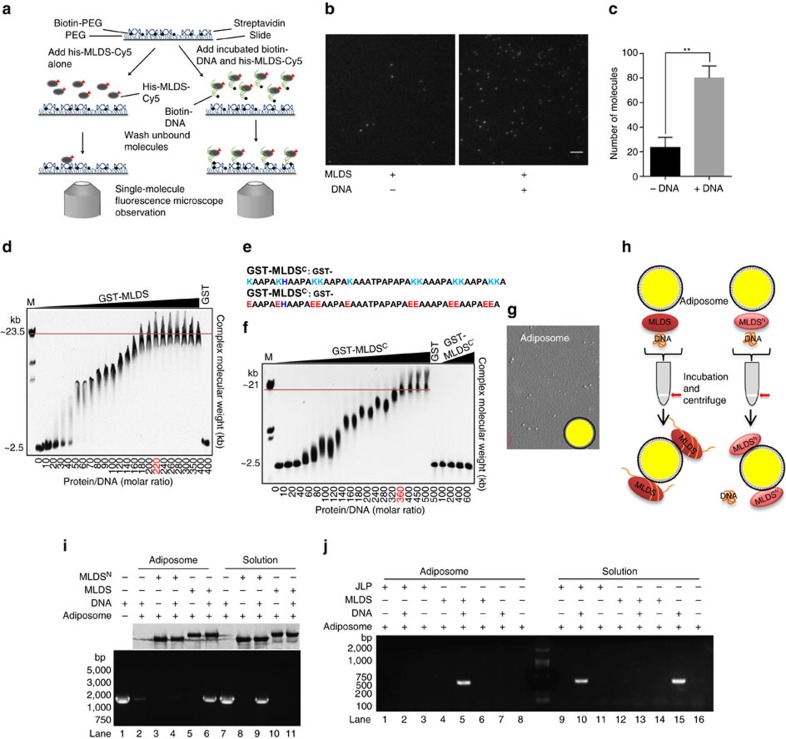
Lipid droplets bind DNA through MLDS in vitro.(a–c) Interaction between DNA and MLDS was detected by single-molecule pull-down assay. Biotin-labelled DNA was incubated with Cy5-labelled MLDS, and the mixture was immobilized onto the streptavidin-coated coverslips and Cy5-labelled MLDS was observed. Sketch (a), validation (b) and quantification (c) of single-molecule pull-down assay were shown. The Cy5-labled MLDS non-specificly bound to the PEG-passivated surface is shown in left. Scale bar, 3.5 μm. Data represent mean±s.d., n=3. **P<0.01, two-tailed t-test. (d) EMSA analysis of the interaction between DNA and MLDS. A dose dependent binding of GST-MLDS was obtained. Although these gel shifts were diffused when the protein/DNA ratio was from 20 to 40, these bindings could still be gradually increased since free monomer DNA was decreased with increased protein, and the number of GST-MLDS molecules bound to the 2.5 kb DNA could be saturated at 220 per DNA molecule (red). (e) The amino acid sequence of the MLDS C-terminus (MLDSC) and the MLDS C-terminal mutant (MLDSC′). All lysine in the region was replaced by glutamic acids. (f) EMSA analysis of MLDSC and MLDSC′ with DNA. The 2.5 kb DNA molecule bound a maximum of 360 molecules of MLDSC (red). (g) The morphology and model of adiposomes. (h,i) Sketch (h) and validation (i) of adiposome-binding assay using adiposomes, DNA, and MLDS or MLDS N-terminus (MLDSN). DNA, proteins and adiposomes were incubated and then the reaction was centrifuged to separate the adiposomes from the solution. DNA was detected by PCR and EB stained agarose gel (bottom). Protein was detected by silver staining (top). Lanes 4 and 9: MLDSN, DNA and adiposomes; lanes 6 and 11: MLDS, DNA and adiposomes. Lanes 2–6 represented adiposome samples; lanes 7–11 represented solution samples. MLDSN and MLDS represented GST- MLDSN and GST-MLDS, respectively. (j) Similar to i, validation of adiposome-binding assay using adiposomes, DNA, and MLDS or JLP. Lanes 2 and 10: JLP, DNA and adiposomes; lanes 5 and 13: MLDS, DNA and adiposomes. JLP represented GST-JLP.